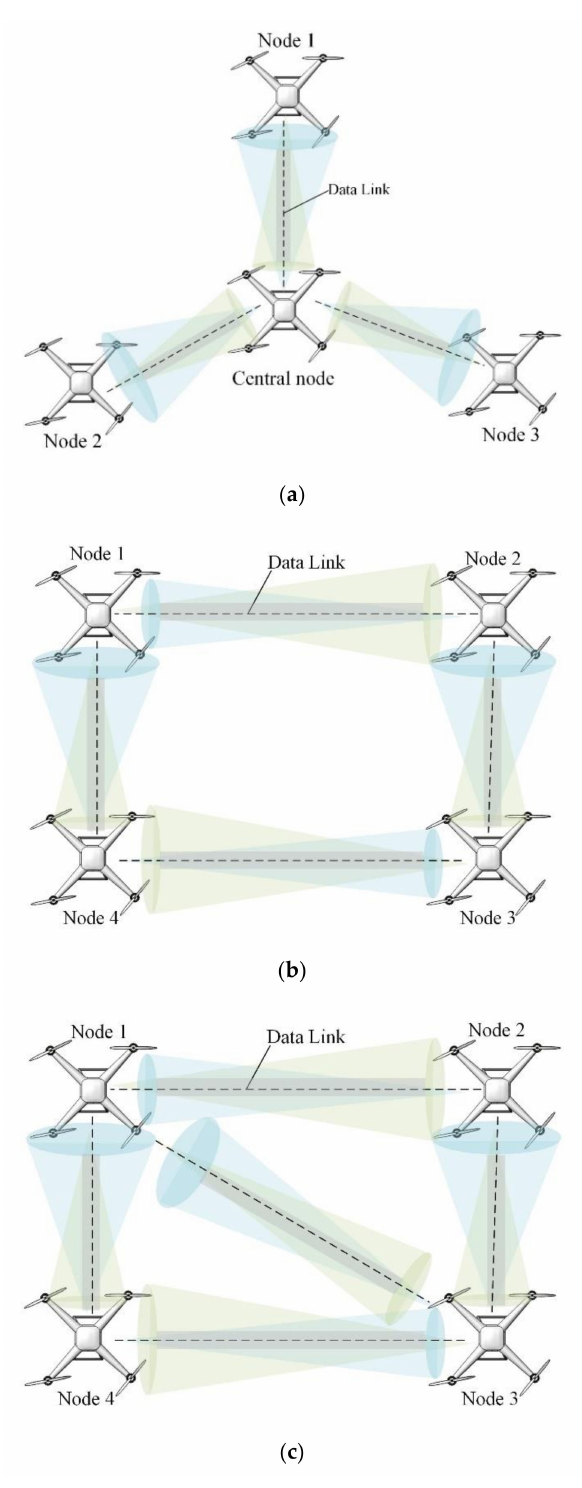
Figure 6. UAV swarm: ( a ) star architecture; ( b ) ring architecture; and ( c ) meshed